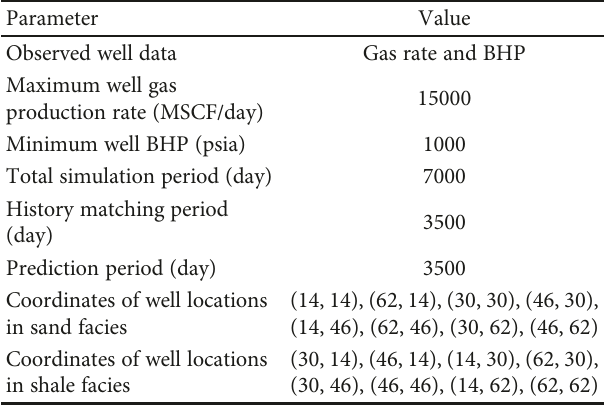
Table 4: Number of parameters used for construction and update of sparse geologic